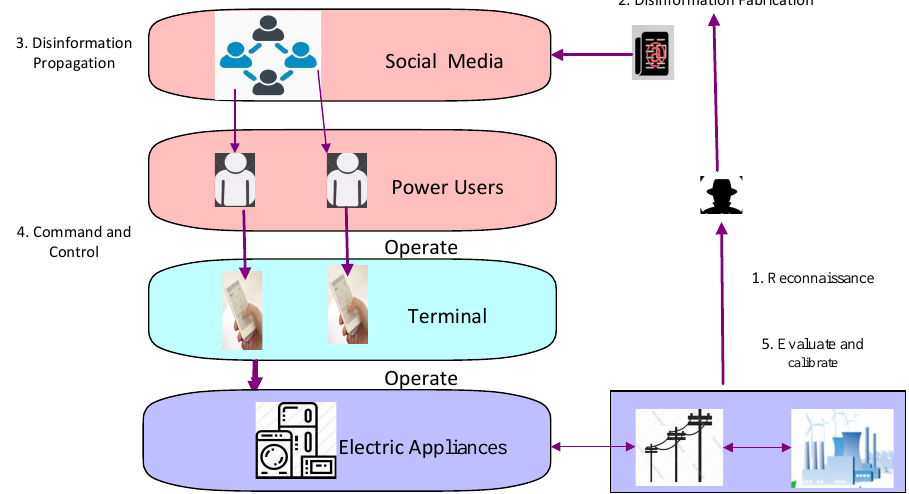
Figure 6. Steps of Social Collective Attack on CPS